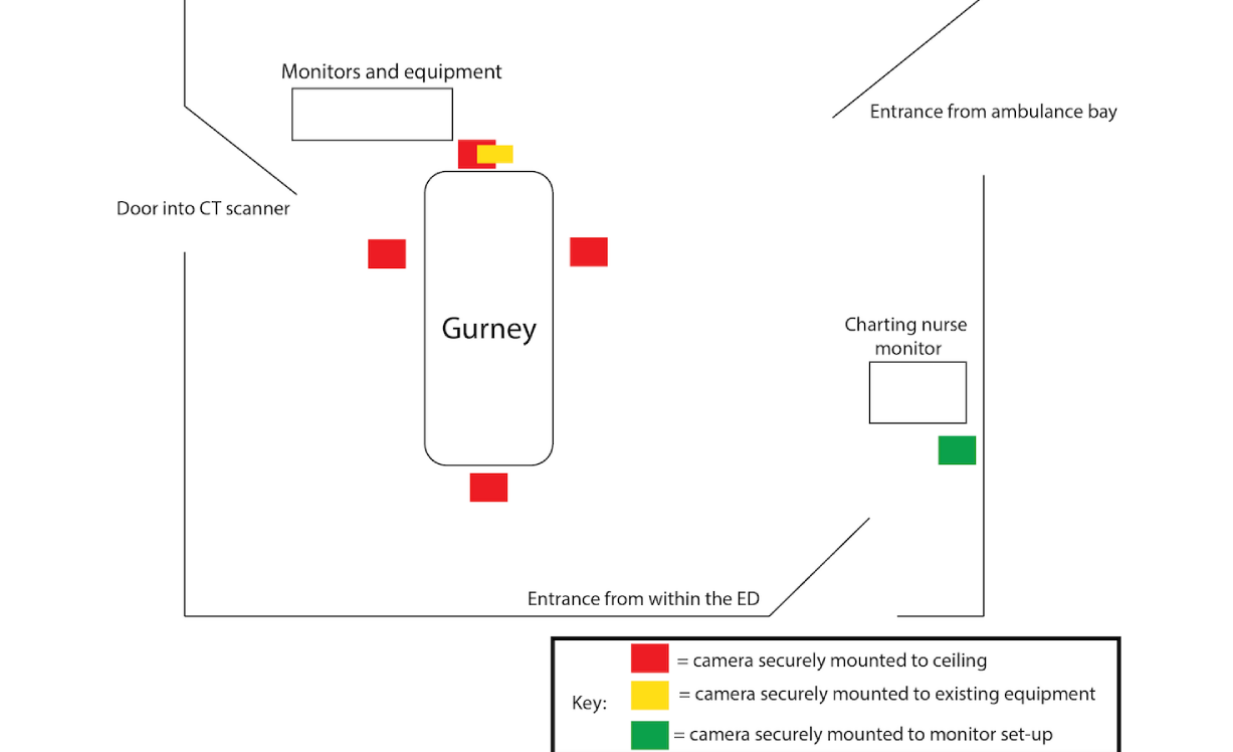
Figure 1. Schematic of equipment set-up in the selected trauma resuscitation room. CT: computed tomography; ED: emergency